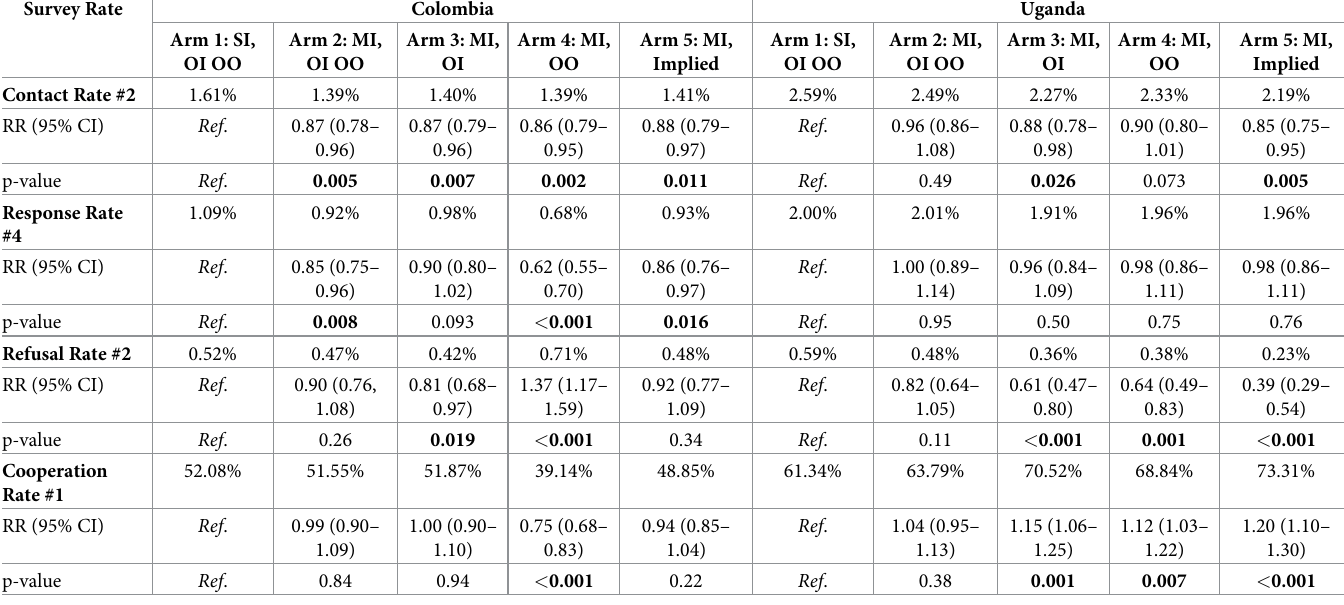
Table 2. Survey rates and risk ratio by study arm in Colombia and Uganda. Survey Rate